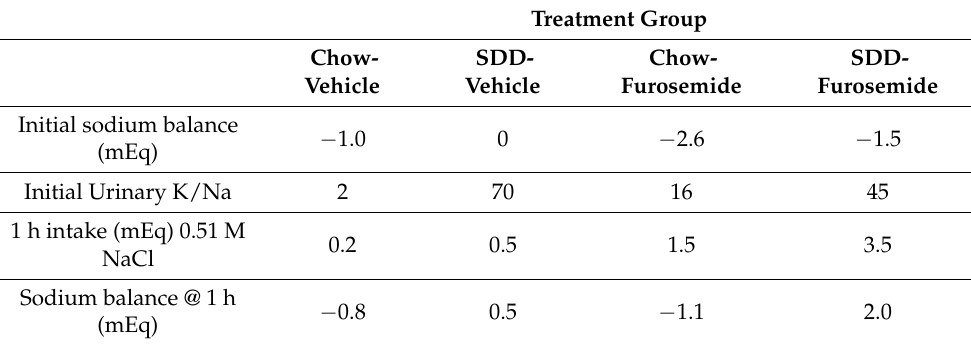
Table 3. Sodium intake and balance during first hour test conducted 24 h after furosemide or vehicle treatment with differential prior dietary exposure a